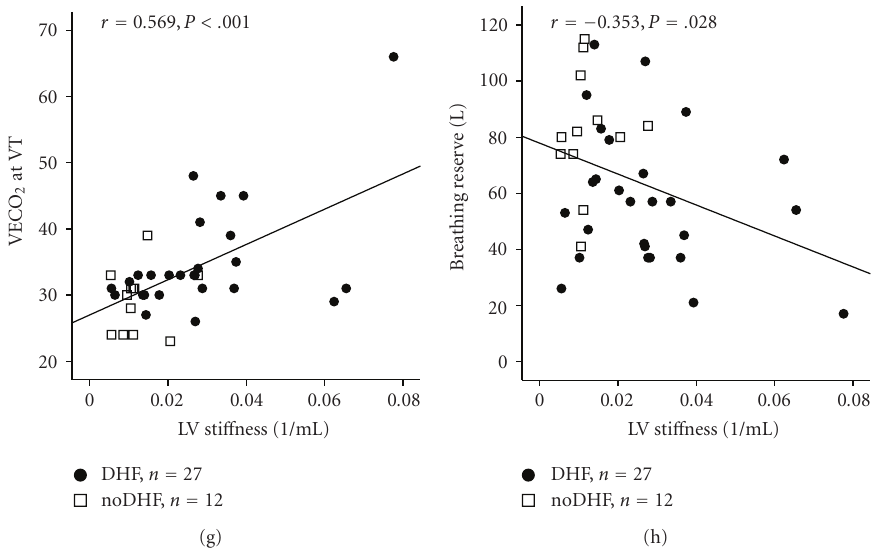
Figure 3: Linear regression between CPET indices and LV sti ff ness in all patients. VO 2 indicates peak oxygen uptake, VT ventilatory threshold, VECO 2 ventilation equivalent for carbon dioxide output, VEO 2 ventilation equivalent for oxygen uptake, sti ff ness beta exponential curve fit to end-diastolic PV relationship, r correlation coe ffi cient, and P significance